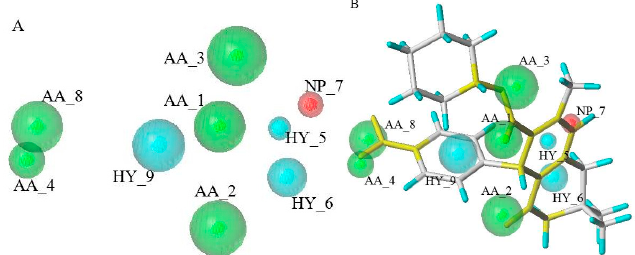
Figure 2. The optimal GALAHAD pharmacophore model of CDK2 allosteric inhibitors ( A ) and the allosteric compound BAS00380830 mapped with the optimal GALAHAD pharmacophore model ( B ). AA means hydrogen bond acceptors; HY means hydrophobic features; NP means positive nitrogen.